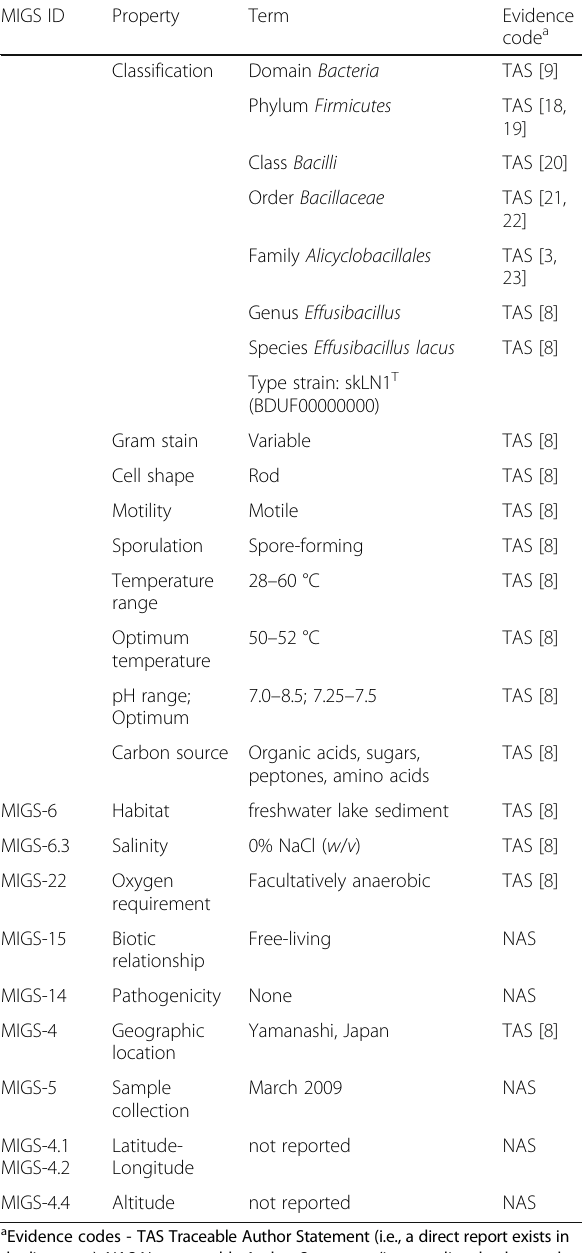
Table 1 Classification and general features of Effusibacillus lacus strain skLN1 T according to MIGS recommendations